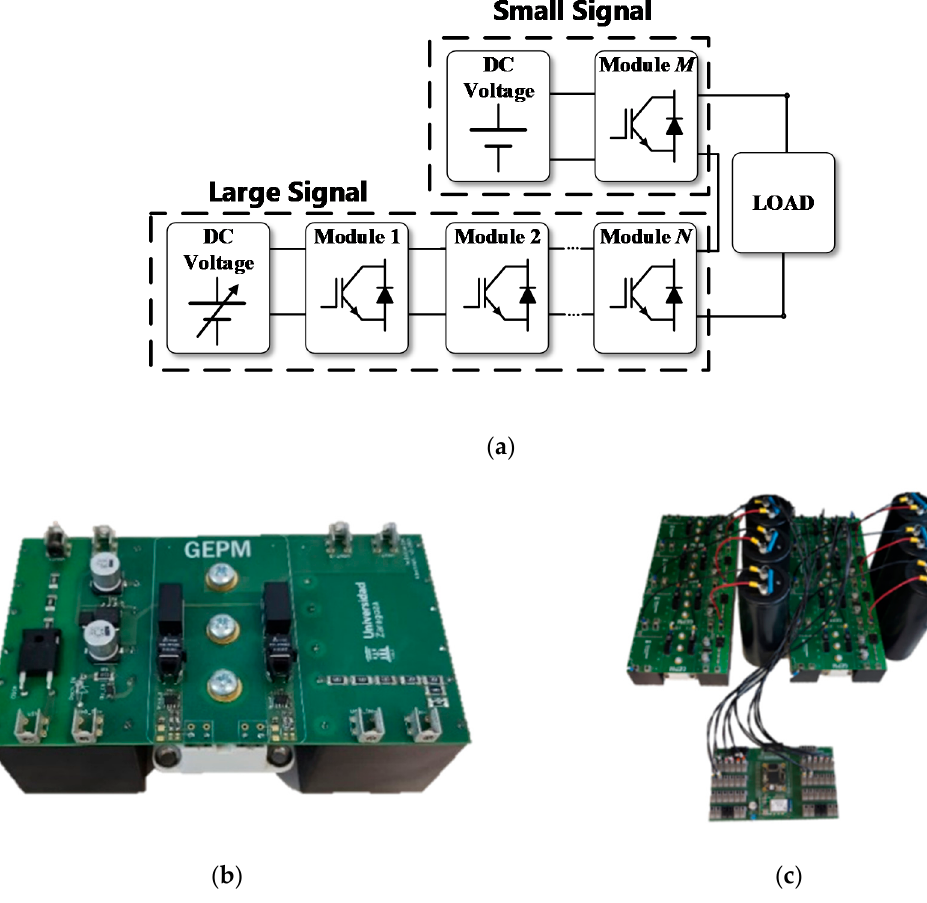
Figure 2. High-voltage generator for electroporation: ( a ) general block diagram, ( b ) single module and ( c ) high-voltage generator used in the experimental measurements.